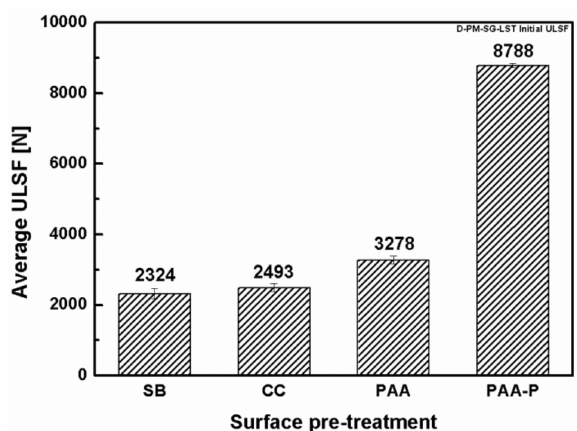
Figure 10. Initial strength of the SLS FSp joints before accelerated